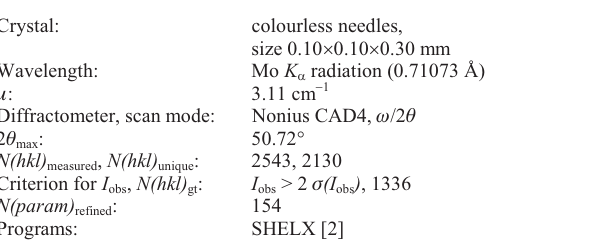
Table 1. Data collection and handling.